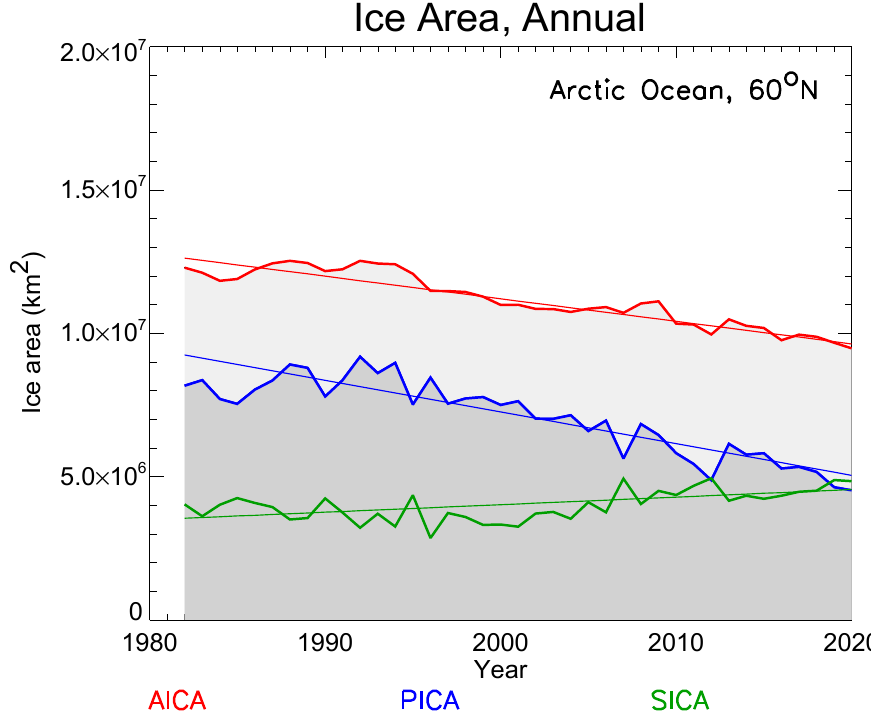
Figure 2. Time series of Arctic seasonal, perennial, and all ice-covered areas on a yearly basis within the Arctic area north of 60 ◦ N degree. SICA (green) stands for seasonal ice-covered area, PICA (blue) denotes perennial ice-covered area, and AICA (red) is the sum of SICA and PICA.